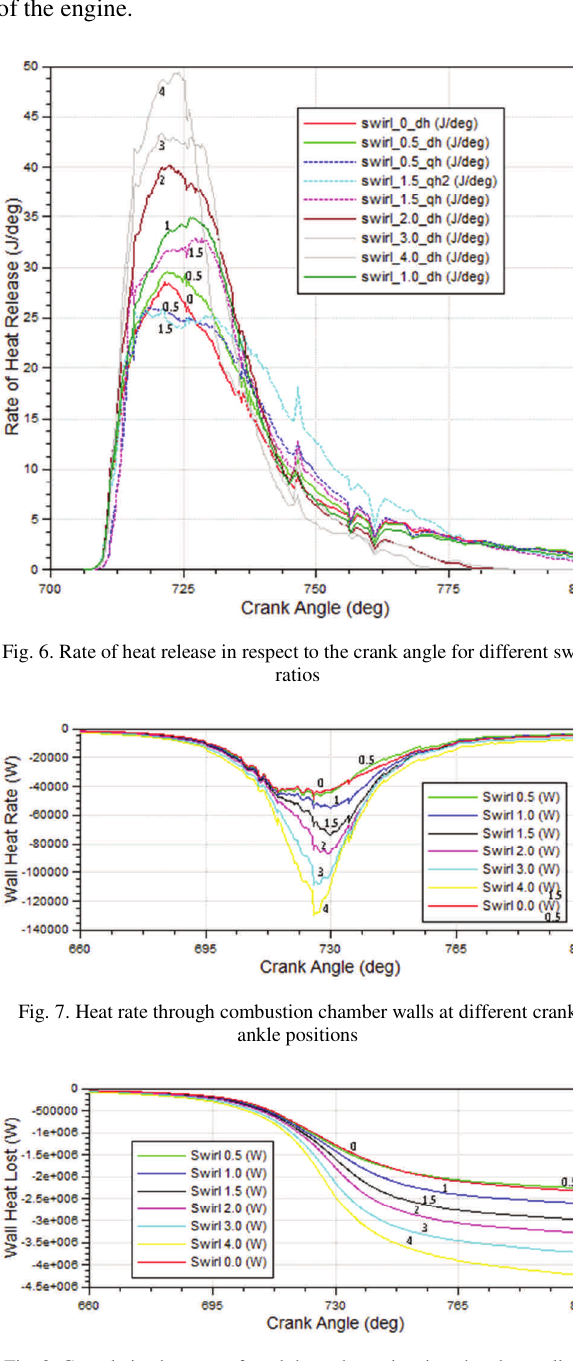
Fig. 8. Cumulative heat transferred through combustion chamber walls at different crank angle positions The results show that the heat flux can vary vastly with the change of swirl ratio, injection parameters and combus- tion chamber geometry. It is very important not to exceed the temperature limits if the piston materials. The tempera- ture affects piston strength limits and its thermal